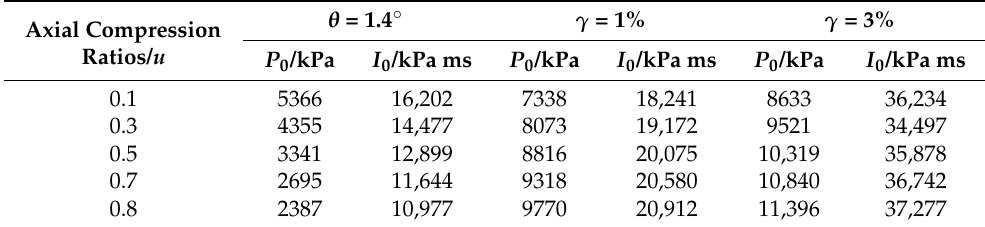
Figure 24. P-I curves of bending response with different axial compression ratios. Table 13. Effect of axial compression ratios on